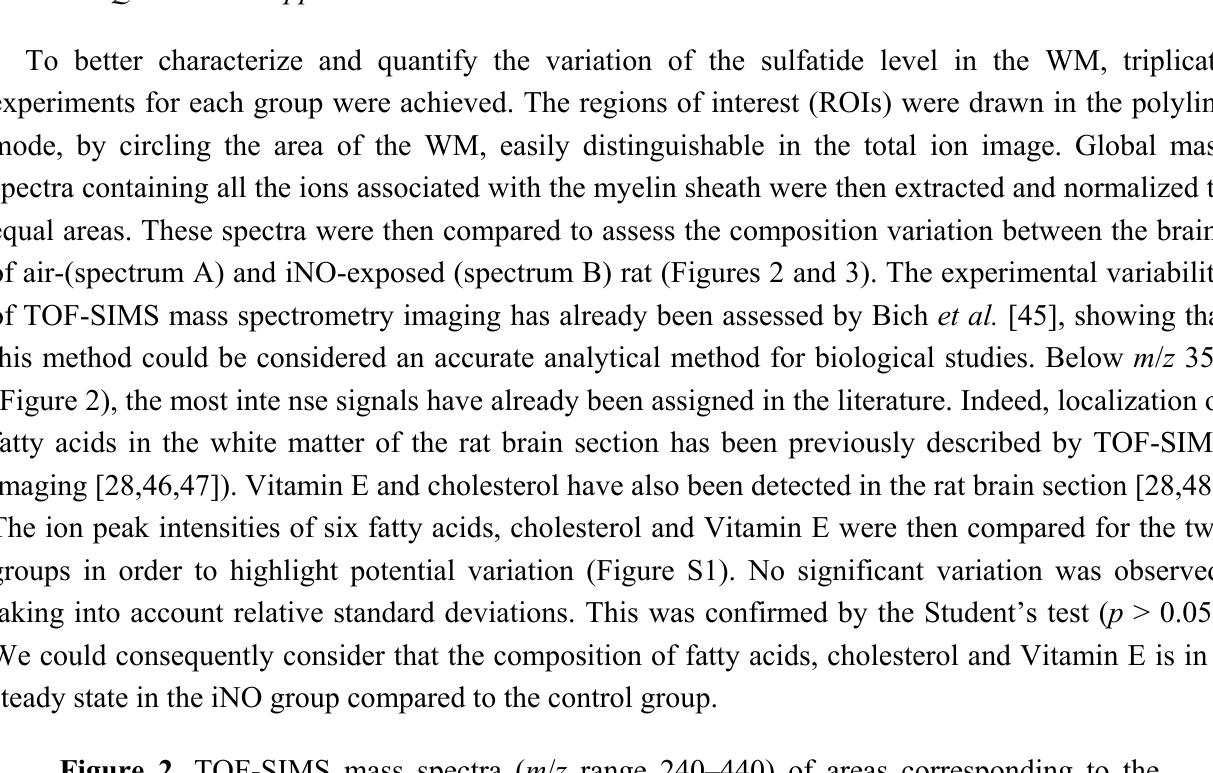
Figure 2. TOF-SIMS mass spectra ( m / z range 240–440) of areas corresponding to the white matter of P10 rat brain tissue sections. ( A ) air-exposed rat; ( B ) iNO-exposed